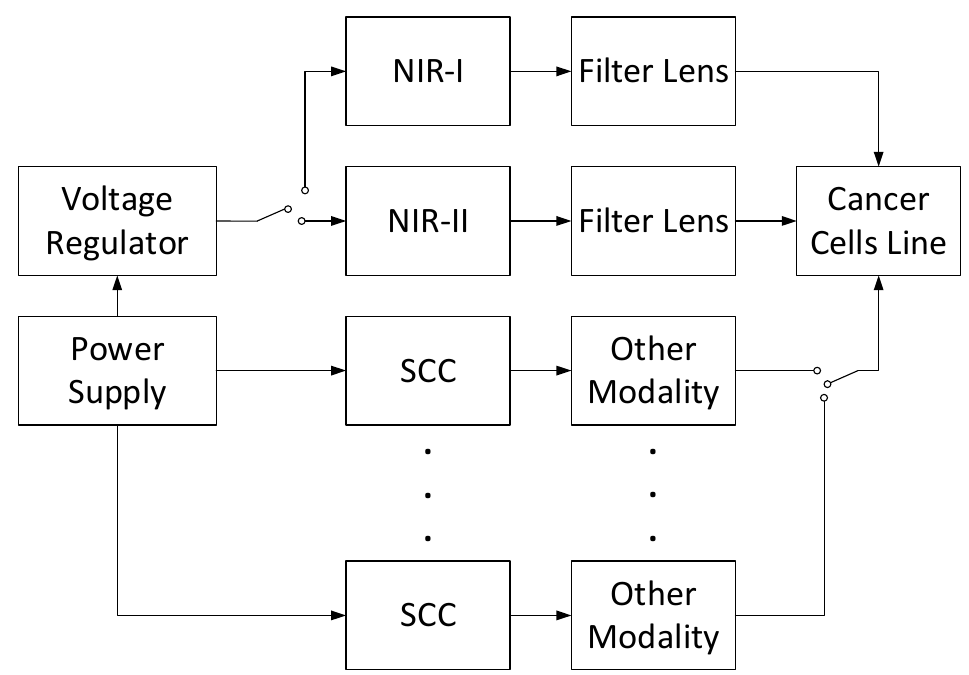
Figure 6. Instrumentation of combined NIR-I and NIR-II along other modalities. Finally, a novel cancer cell suppressor with the combination of CW, FD, and TD can be designed, as shown in Figure 7. As DOT has demonstrated a promising ability to image the soft tissue with the NIR light penetration, three NIR light types may be applied to establish the cancer cell growth control apparatus. A voltage generator can be implemented to supply appropriate power for each NIR light type. To focus and filter the NIR light for only targeted cancer cells, one can place the filter lens in front of each NIR light source type. The measurement is completed when the comparisons among individual light sources emitting the cancer cell and their combinations are obtained.